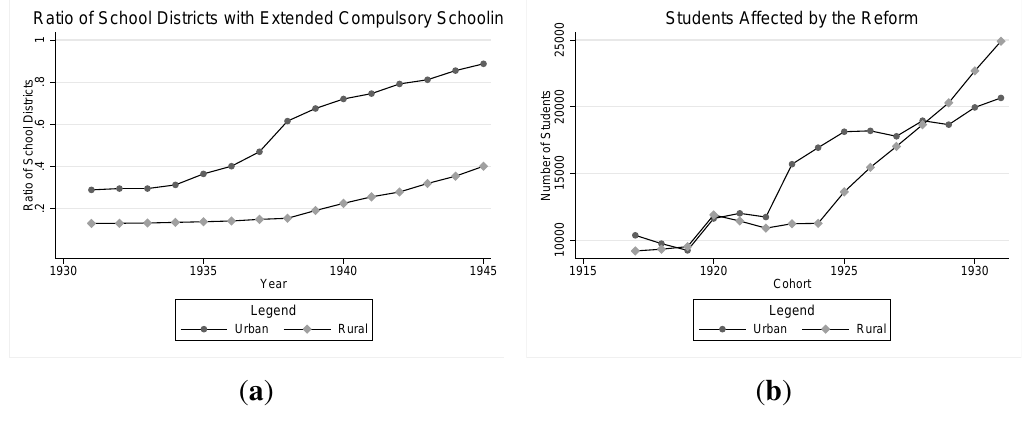
Figure 1. ( a ) Proportion of school districts with seven years of compulsory schooling; ( b ) number of students